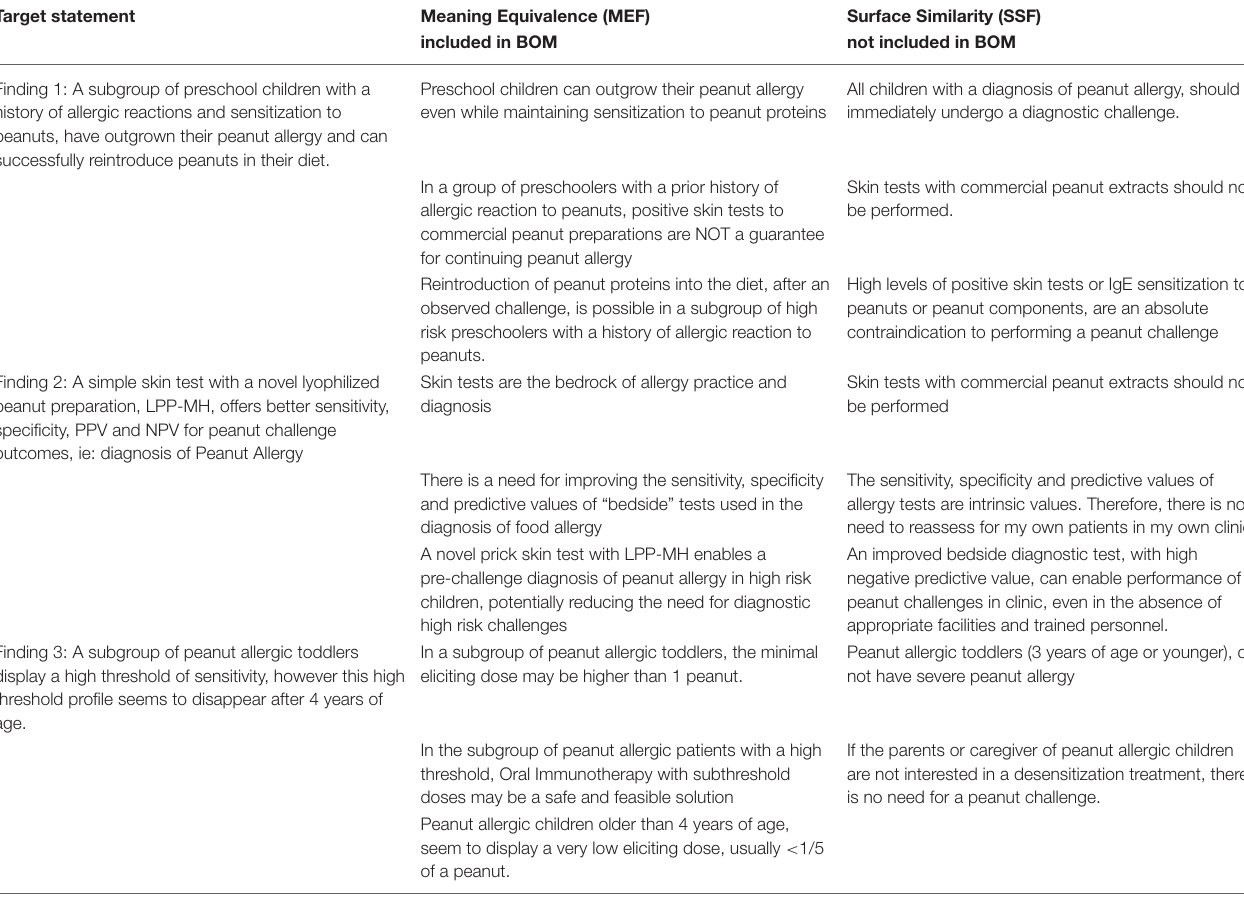
TABLE 5 | Generalization of study